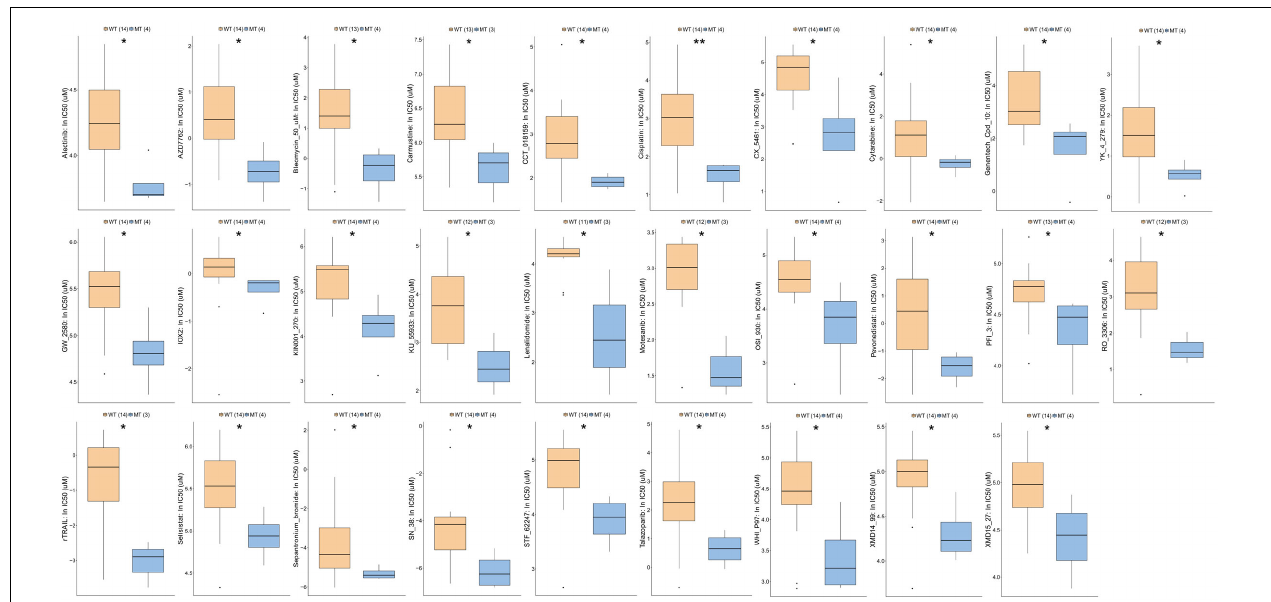
FIGURE 5 | Comparison of drug sensitivity between ATM-MT and ATM-WT in the GDSC-Bladder cancer cell line cohort. We observed that the sensitivity to 29 drugs were increased in the ATM-MT group ( P < 0.05), including Alectinib, AZD7762, Bleomycin, Carmustine, CCT_018159, Cisplatin, CX_5461, Cytarabine, Genentech_Cpd_10, YK_4_279, GW_2580, IOX2, KIN001_270, KU_55933, Lenalidomide, Motesanib, OSI_930, Pevonedistat, PFI_3, RO_3306, rTRAIL, Selisistat, Sepantronium_bromide, SN_38, STF_62247, Talazoparlb, WHI_P97, XMD14_99, and XMD15_27. IC50s reported in GDSC were log-transformed. Using the Mann–Whitney U test tested the differences in the ln(IC50) values of different drugs between the ATM-MT and ATM-WT cell lines. * P < 0.05; ** P <